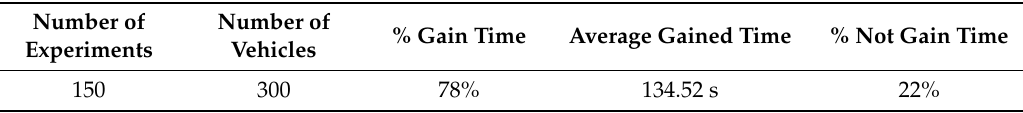
Table 5. Overall results of the experiments in simulation, showing the percentages (%) of vehicles experimenting and not experimenting time gains, along with the average gain in